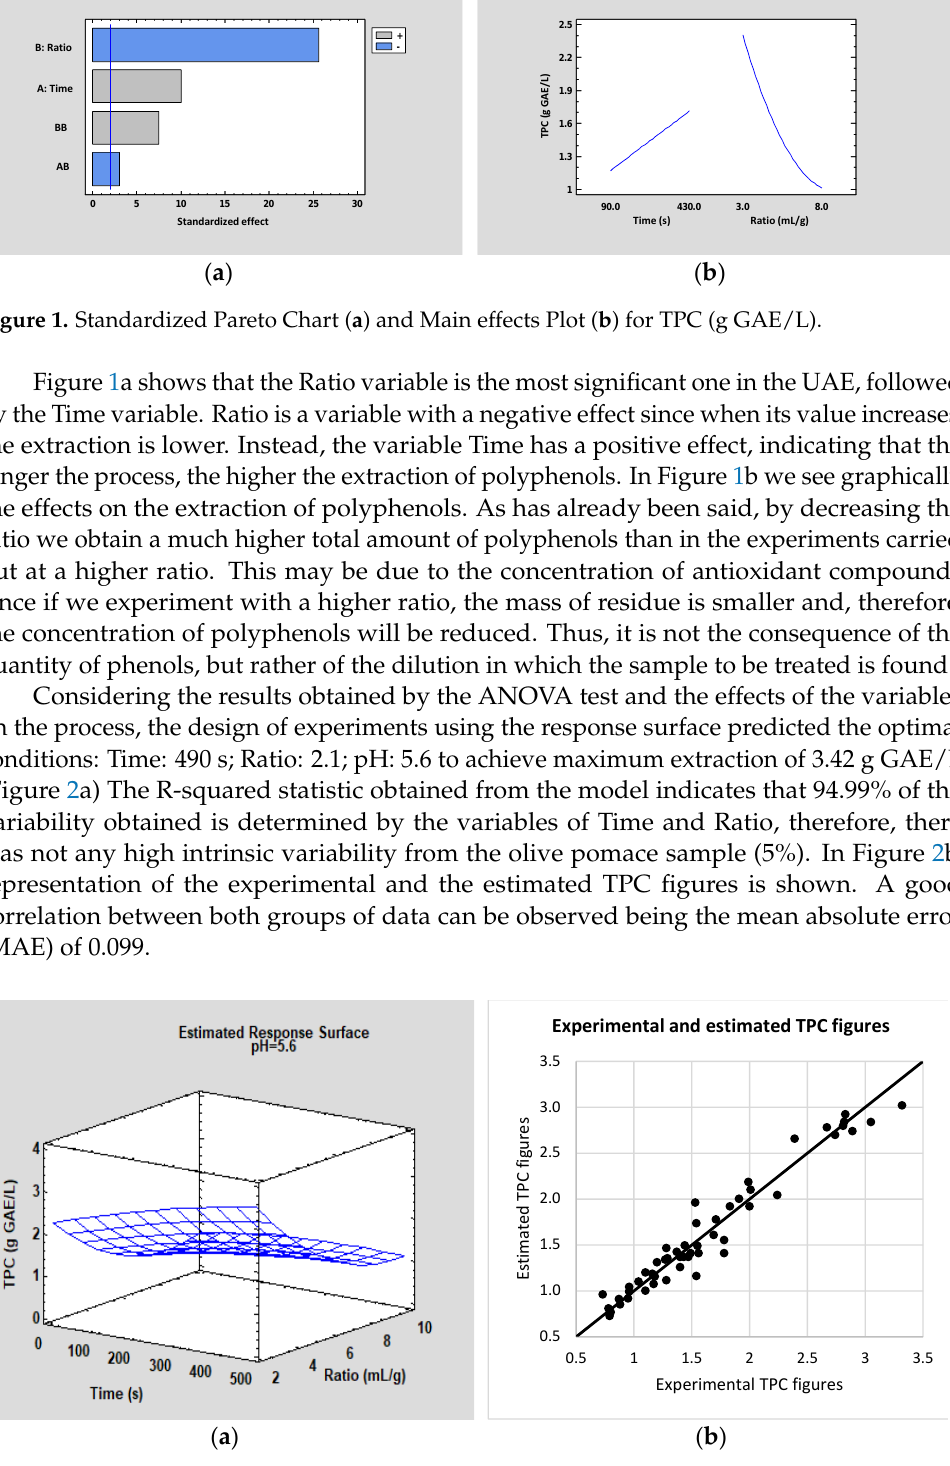
Figure 2. Estimated response surface at Optimal conditions ( a ). Representation of experimental and estimated TPC figures ( b